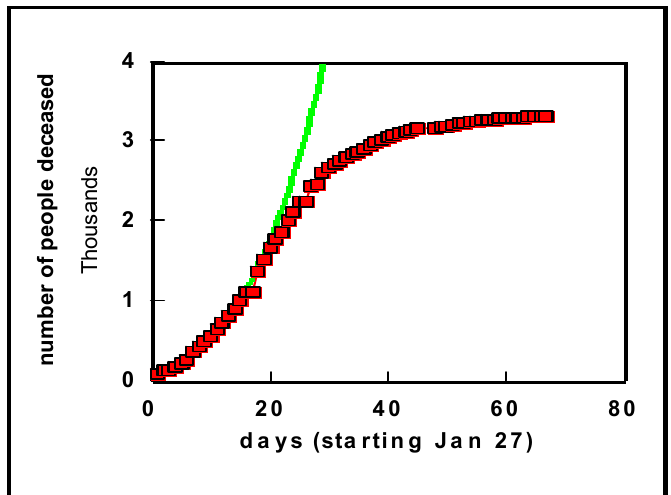
Figure 1. The number of deaths in China as of 27 January 2020 (red squares) and a cubic function fit (separate solid, green, curve) to the first part of the data set. The cubic function reads N 3 /15, where N is the number of days from the start (27 January 2020).